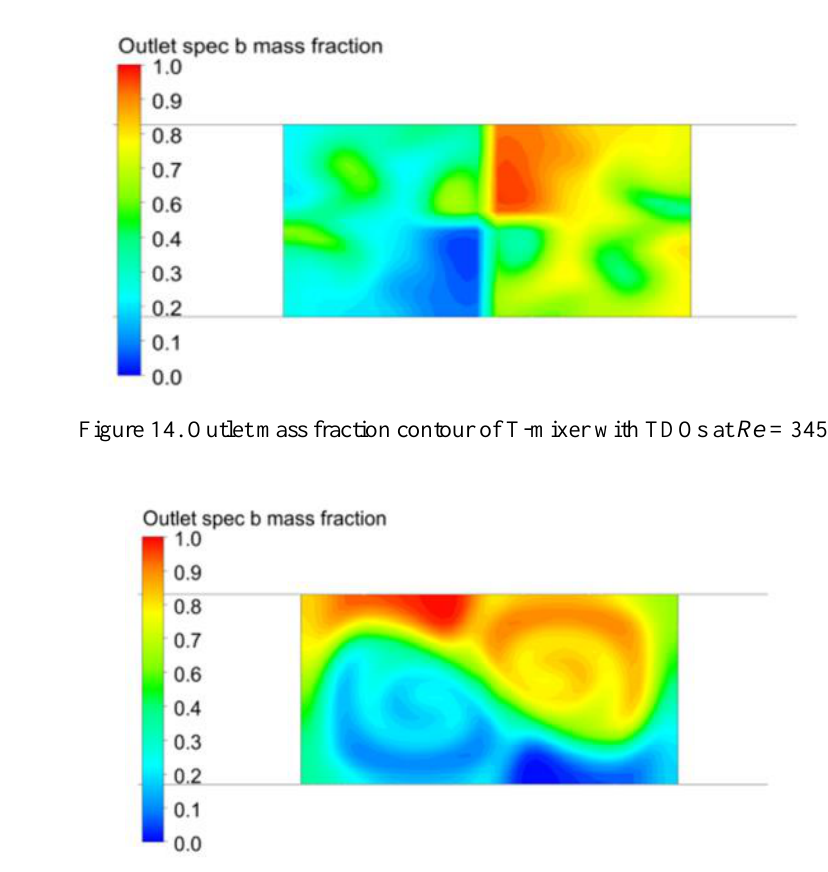
Figure 15. Outlet mass fraction contour of T-mixer at Re =